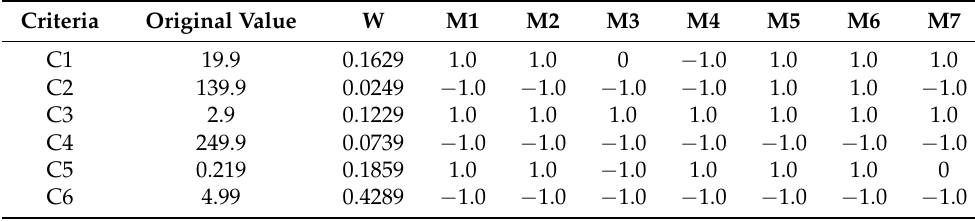
Table 11. First step of PUGH weighing matrix.